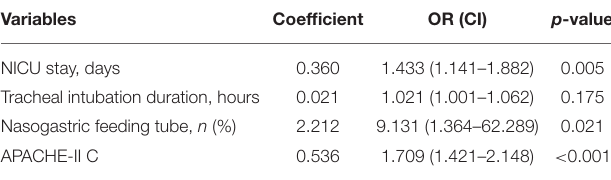
TABLE 2 | Model for prediction of